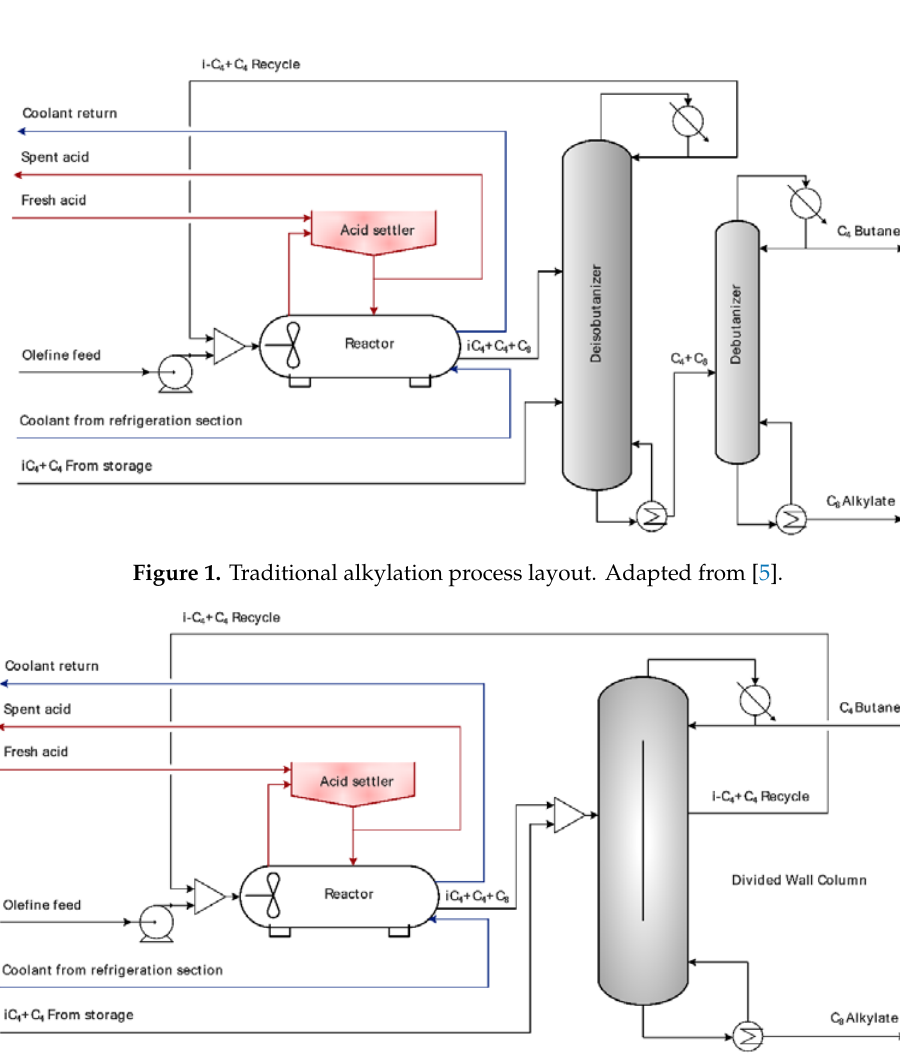
Figure 2. Alkylation process revamp option via divided wall column installation. Adapted from [5].